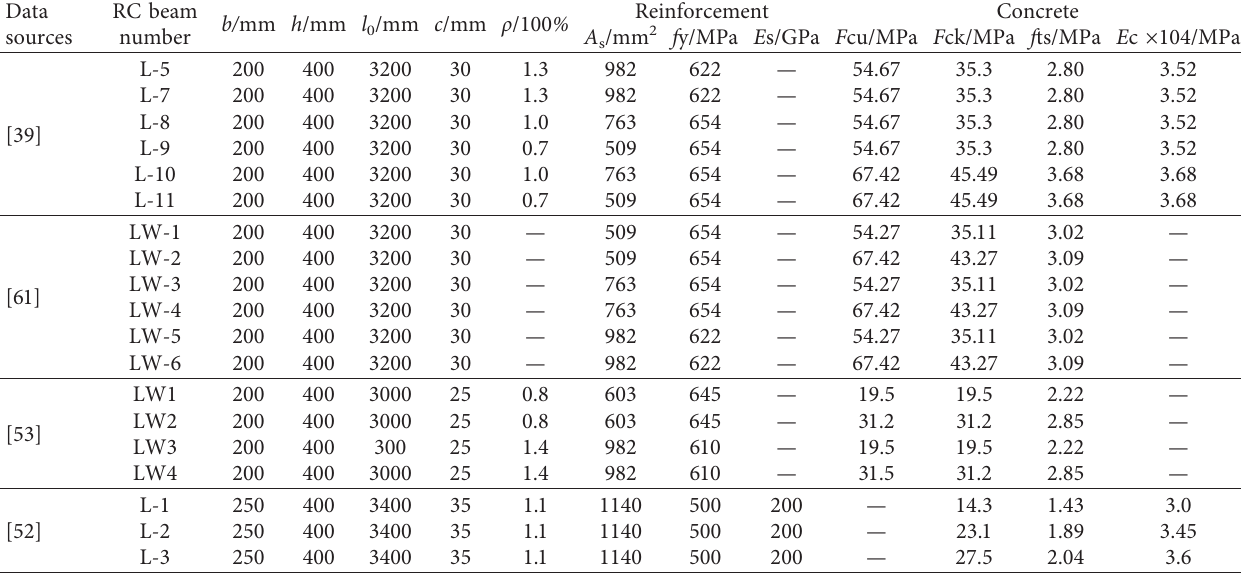
Table 10: Details of beams with 600MPa steel bars.